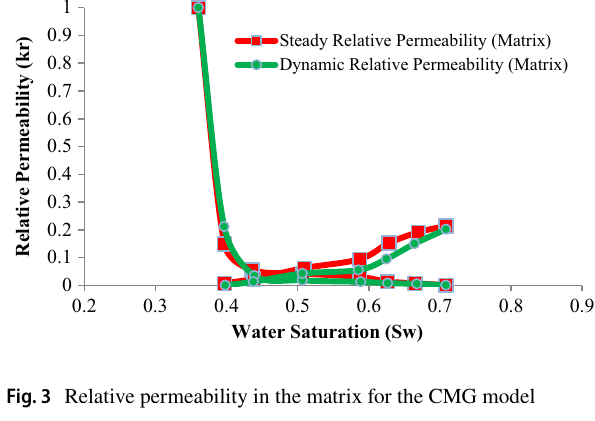
Fig. 3 Relative permeability in the matrix for the CMG model